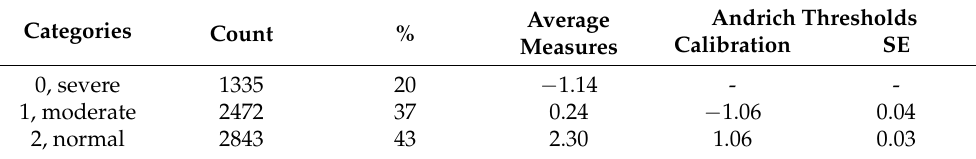
Table 2. Mini-BESTest categories.